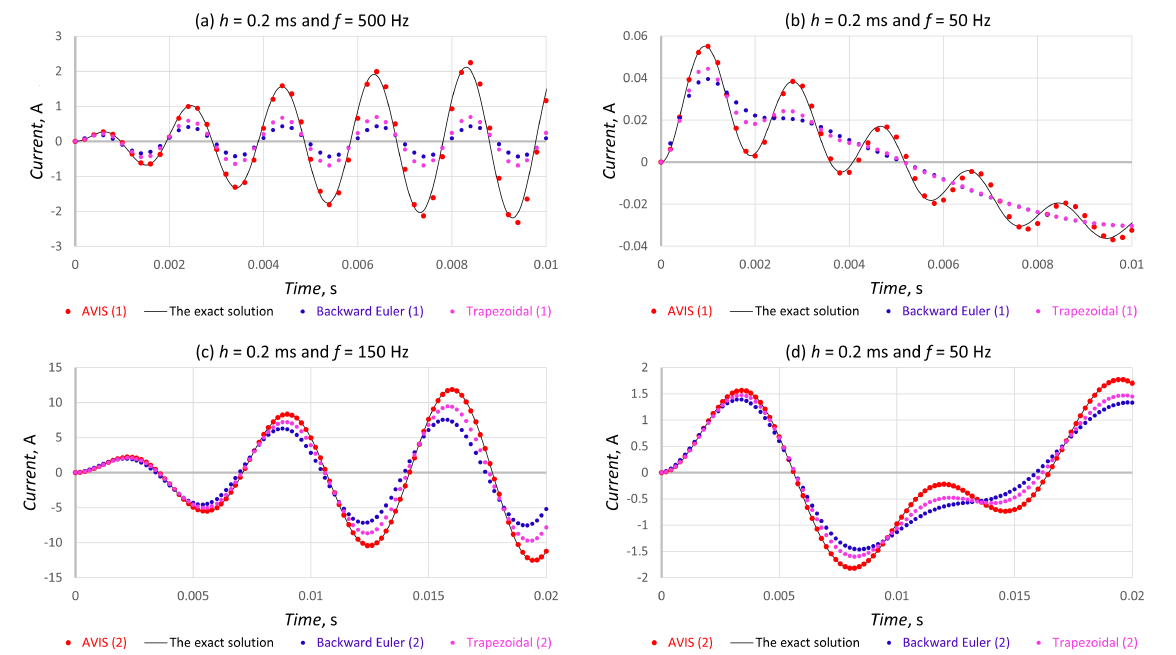
Figure 6. Current waveforms for different integration rules and for different data sets (according to Table